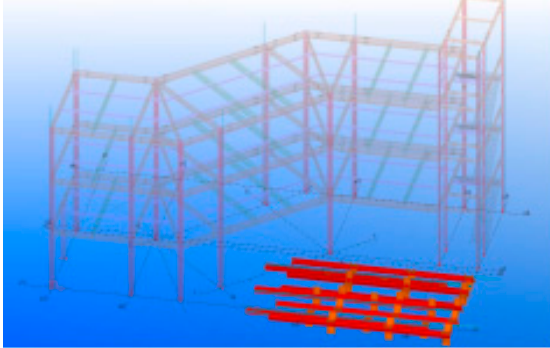
Figure 7. Preliminary review of building and member laydown area.